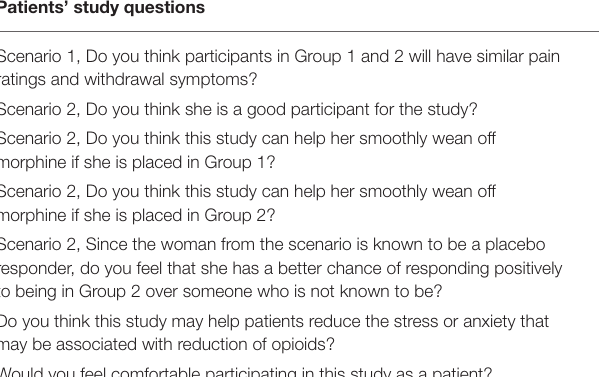
TABLE 1 | Scenario-related questions. Patients’ study